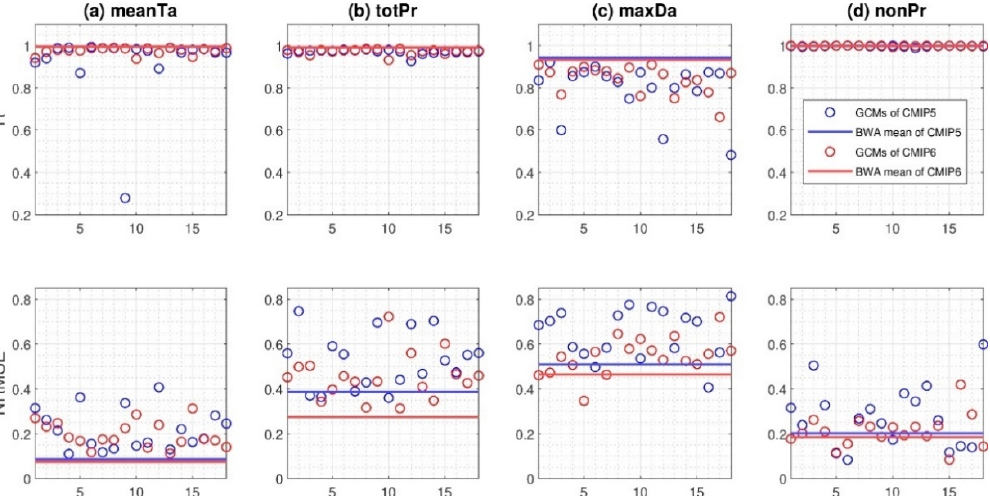
Figure 3. Comparisons of the correlation coefficient (R) and the normalized root mean squared error (NRMSE) for individual 18 GCMs and their BWA mean for the control period: ( a ) meanTa, ( b ) totPr, ( c ) maxDa, and ( d ) nonPr. The R and NRMSE values were calculated for the 520 climatological mean (CM) values of each GCM (and BWA mean) and observations. The NRMSE was normalized by the mean of observations. The 520 refers to 40 locations × 13 (12 months + year).